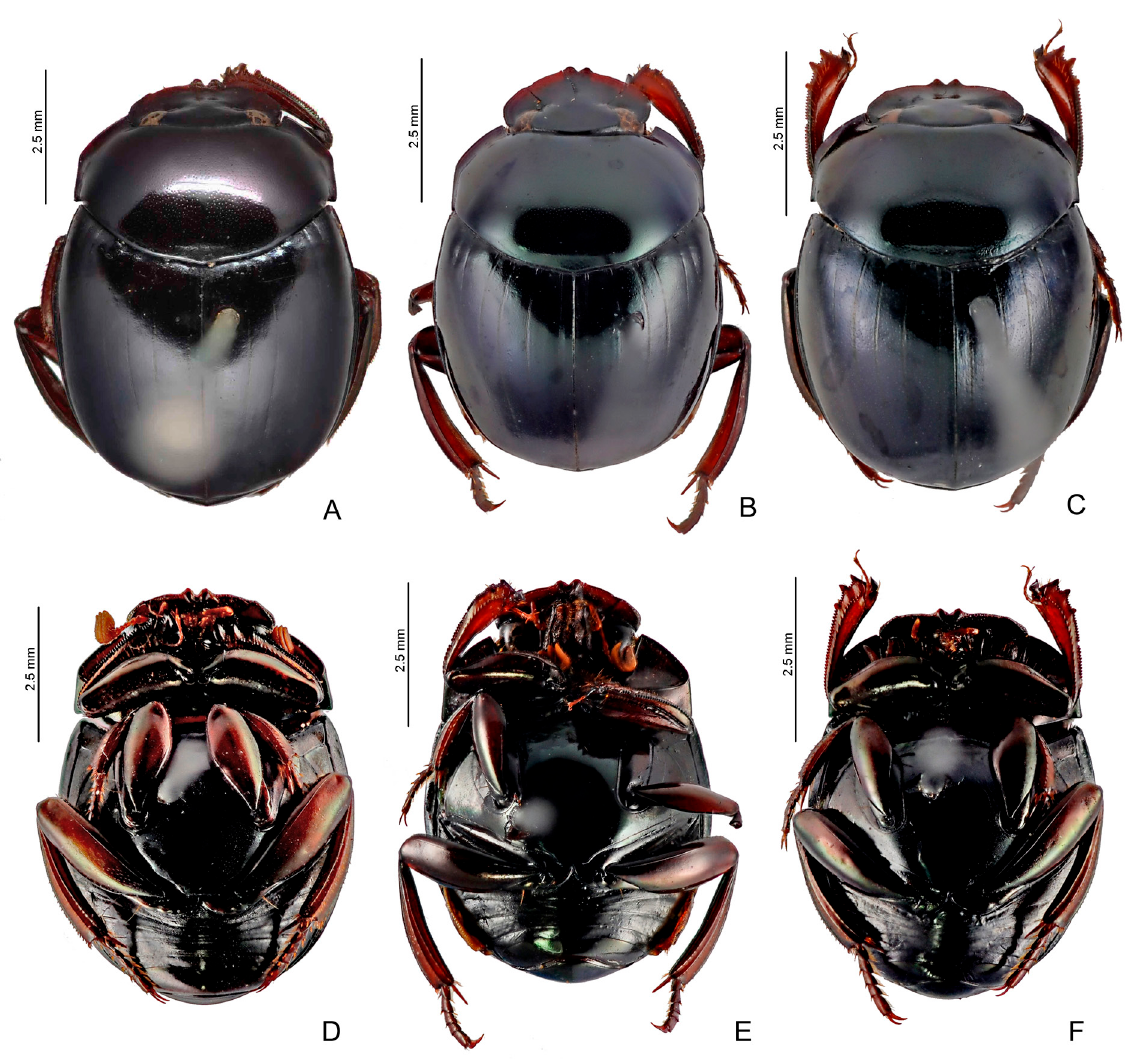
Fig. 43. The three Amazonian species of the furvus subgroup. A, D . Sylvicanthon furvus (Schmidt, 1920). A . Dorsal view. D . Ventral view. B, E . S. monnei sp. nov. B . Dorsal view. E . Ventral view. C, F . S. mayri sp. nov. C . Dorsal view. F . Ventral